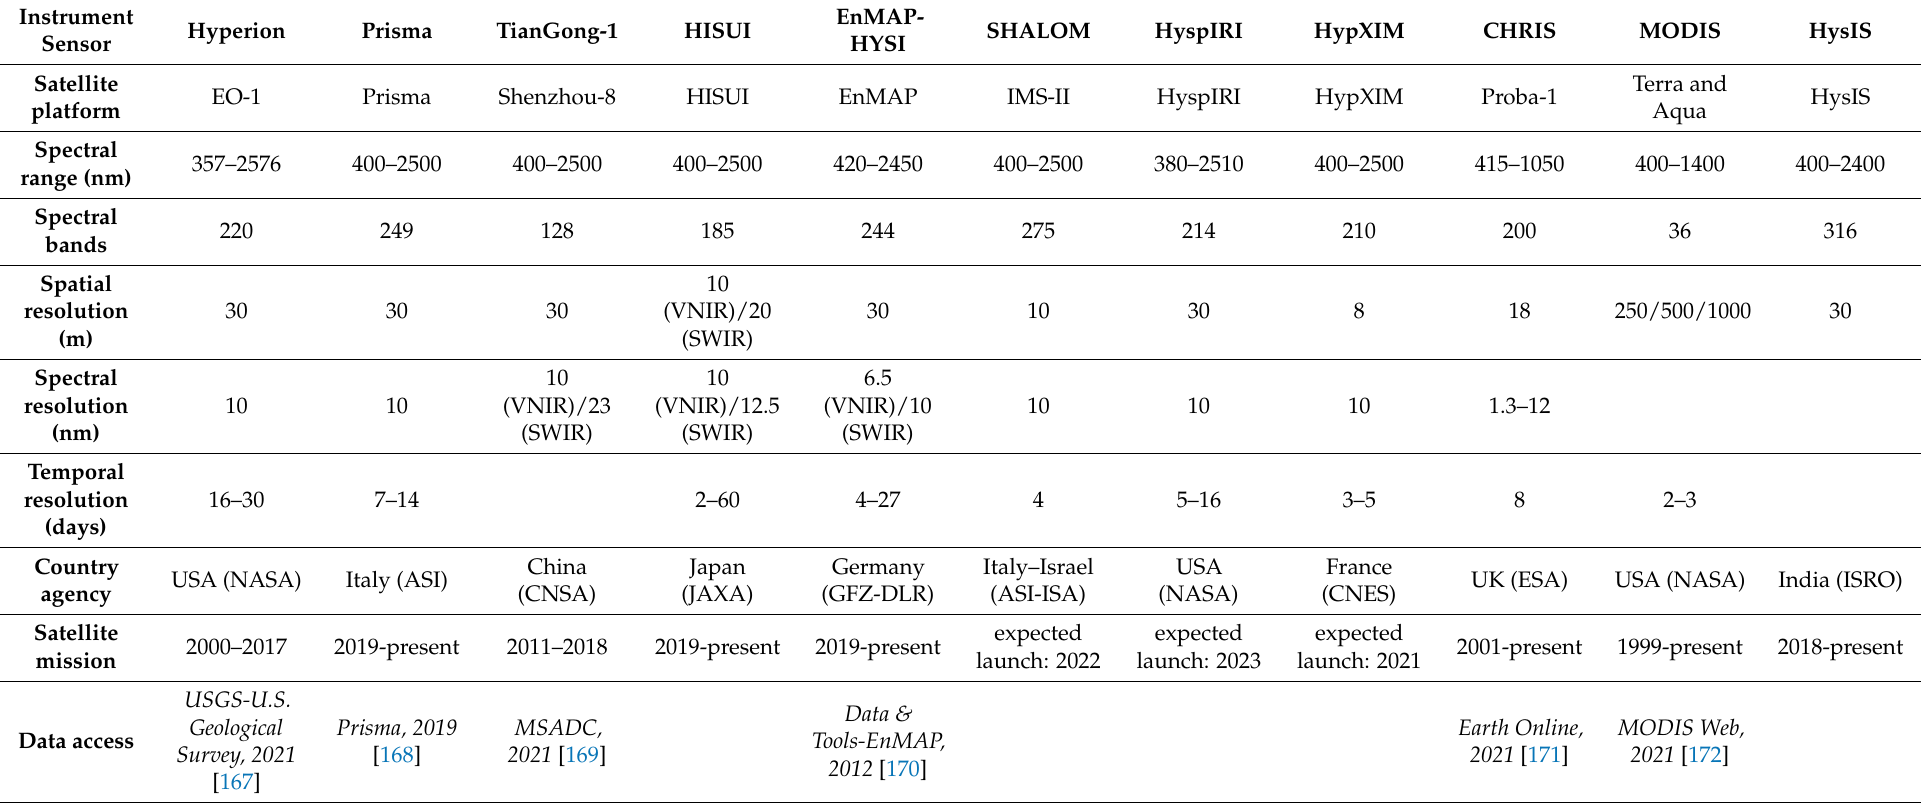
Table 7. Details of hyperspectral space-borne sensors specifications (modified from Transon et al., 2018